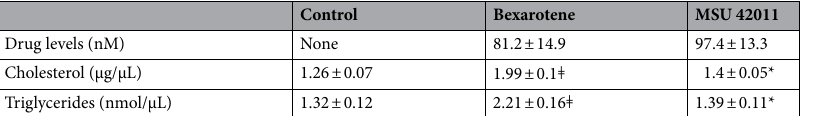
Table 3. Drug levels of rexinoids and cholesterol and triglyceride levels in the plasma of A/J mice. Female A/J mice were fed rexinoids (100 mg/kg diet) or control diet for 12 weeks. Steady state drug levels in plasma were determined by liquid chromatography-mass spectrometry. Cholesterol and triglycerides levels were quantified using commercially available kits as described in the Methods. n = 8 mice/group. ǂ , p < 0.01 vs. control; *, = p < 0.01 vs. bexarotene. Results shown are mean ±